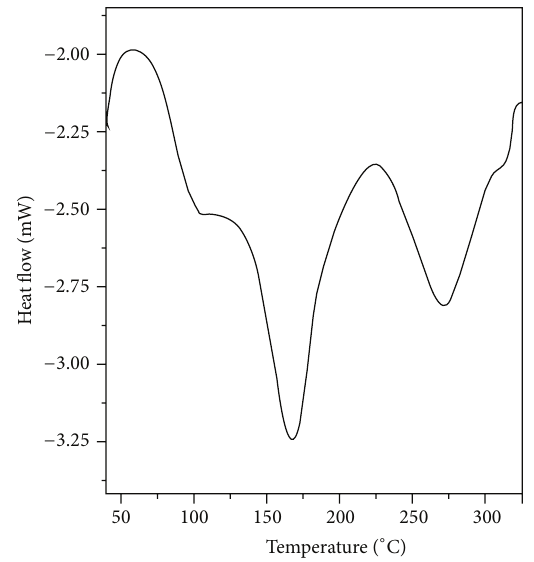
Figure 12: DSC thermogram of